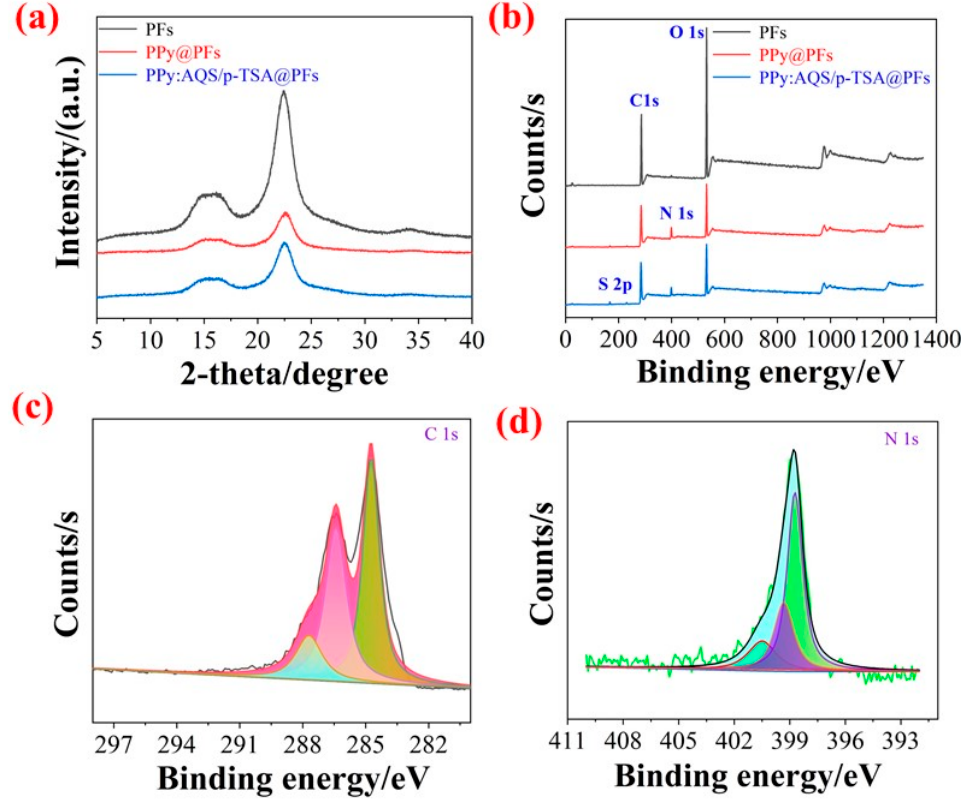
Figure 3. XRD ( a ) and XPS ( b ) images of CFs, PPy@CFs, and PPy:AQS/p-TSA@CFs; XPS C 1s ( c ) and N 1s ( d ) high-resolution spectra of PPy:AQS/p-TSA@CFs paper electrode